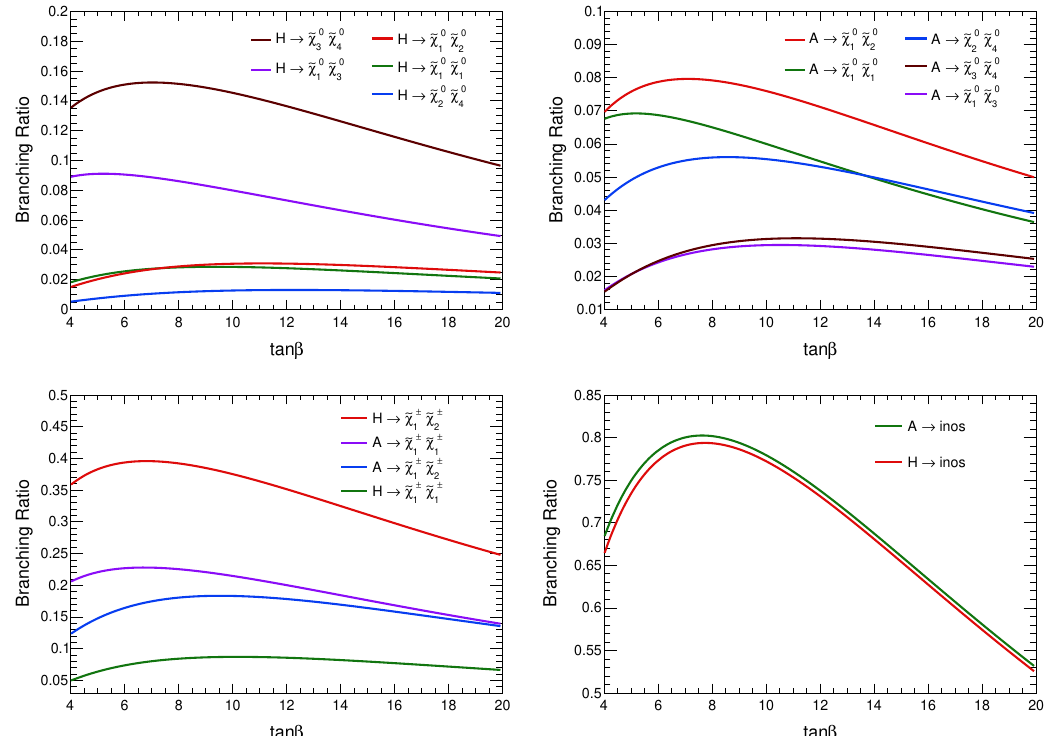
Figure 4. Dominant branching ratios for heavy CP-even and CP-odd Higgs decays to individual electroweakino modes (top panel), the total branching ratio for two heavy Higgs (bottom right), branching ratio of heavy Higgs decaying to charginos (bottom left) for the case-2. The wino, bino, higgsino mass parameters M 2 , M 1 , µ are fixed at 400 , 300 and 350 GeV and tan β is